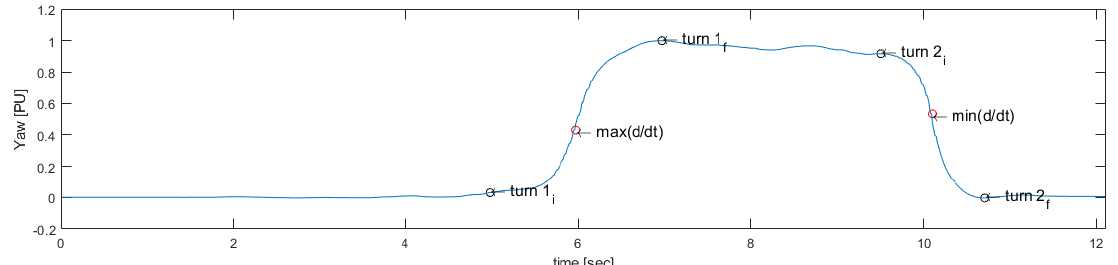
Figure 10. Result of the proposed method for the search of the beginning ( turn 1 i ) and the end ( turn 1 f ) of the 3-m turning event and for the search of the beginning ( turn 2 i ) and the end ( turn 2 f ) of the pre-sitting